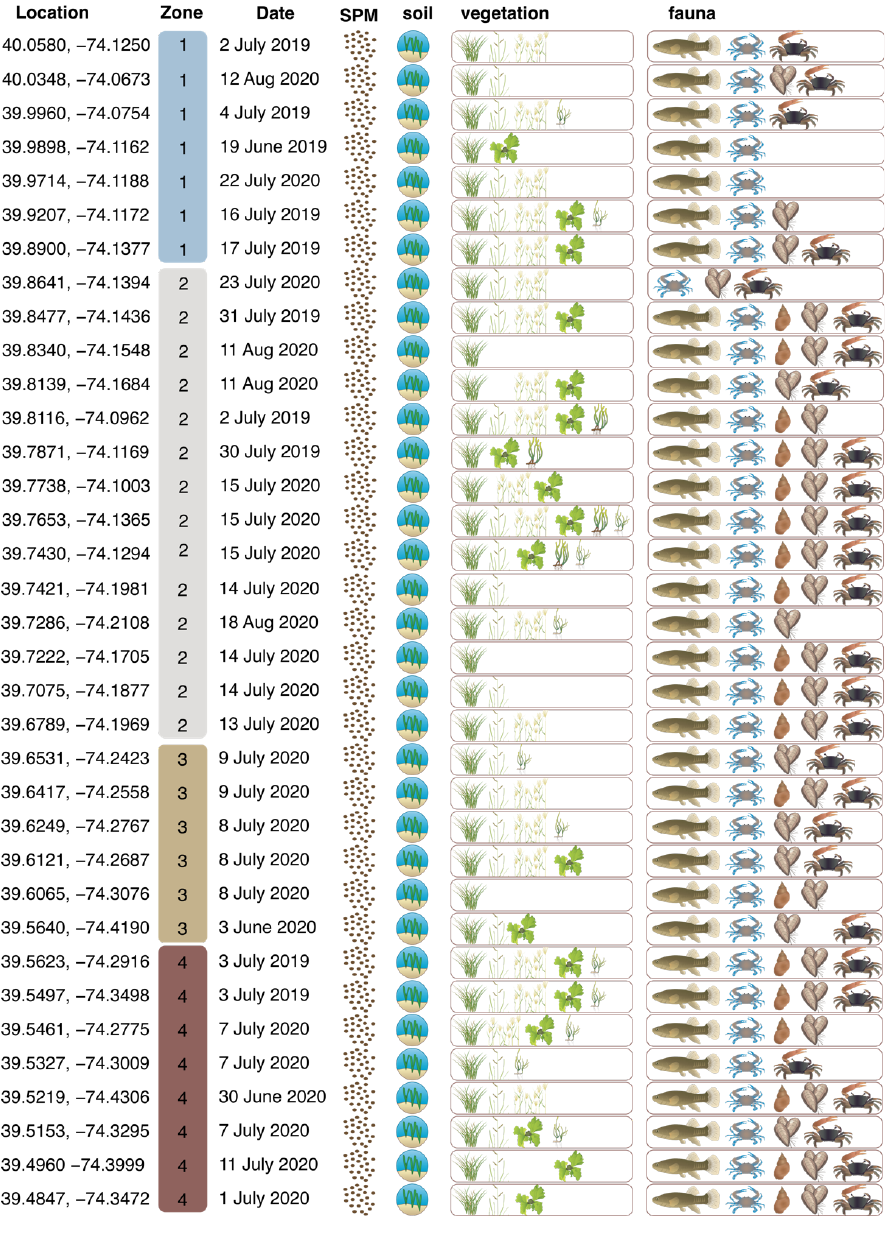
Figure 2. Samples collected and analyzed for stable isotopes of carbon and nitrogen. Plant species from left to right include Spartina alterniflora , Spartina patens , Phragmites australis , Ulva spp., Zostera marina , and Ruppia maritima. Consumer species from left to right include Fundulus spp., Callinectes sapidus (blue crab), Ilyanassa obsoleta (mud snail), Geukensia demissa (ribbed mussel), and Uca spp. (fiddler crab). Images from The University of Maryland Center for Environmental Science Integra- tion and Application Network (IAN; Table S3) (https://ian.umces.edu/media-library/ (accessed on 15 July 2022)). SPM stands for suspended particulate matter.